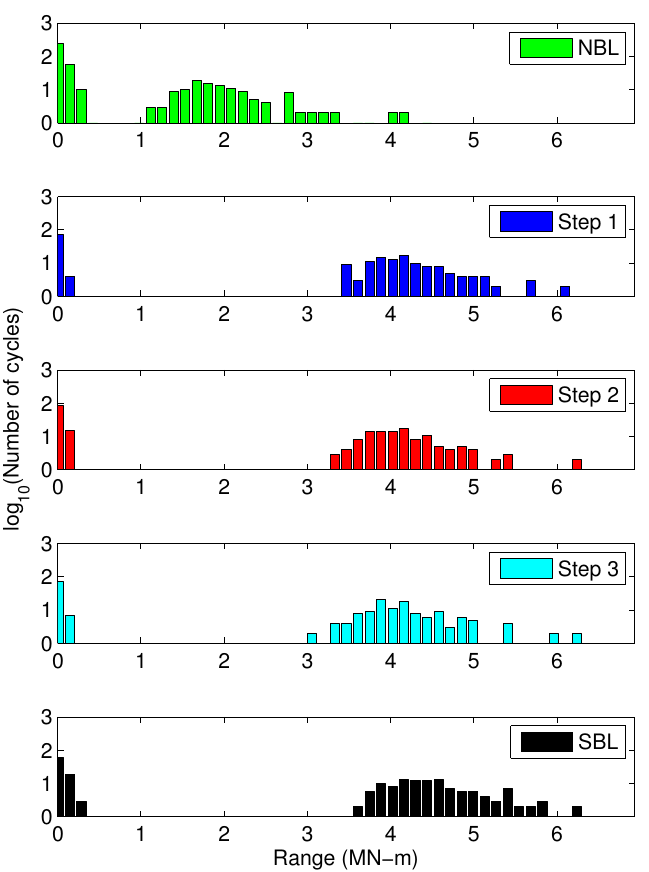
Figure 10. Comparison of OoPBM range histograms for a single case